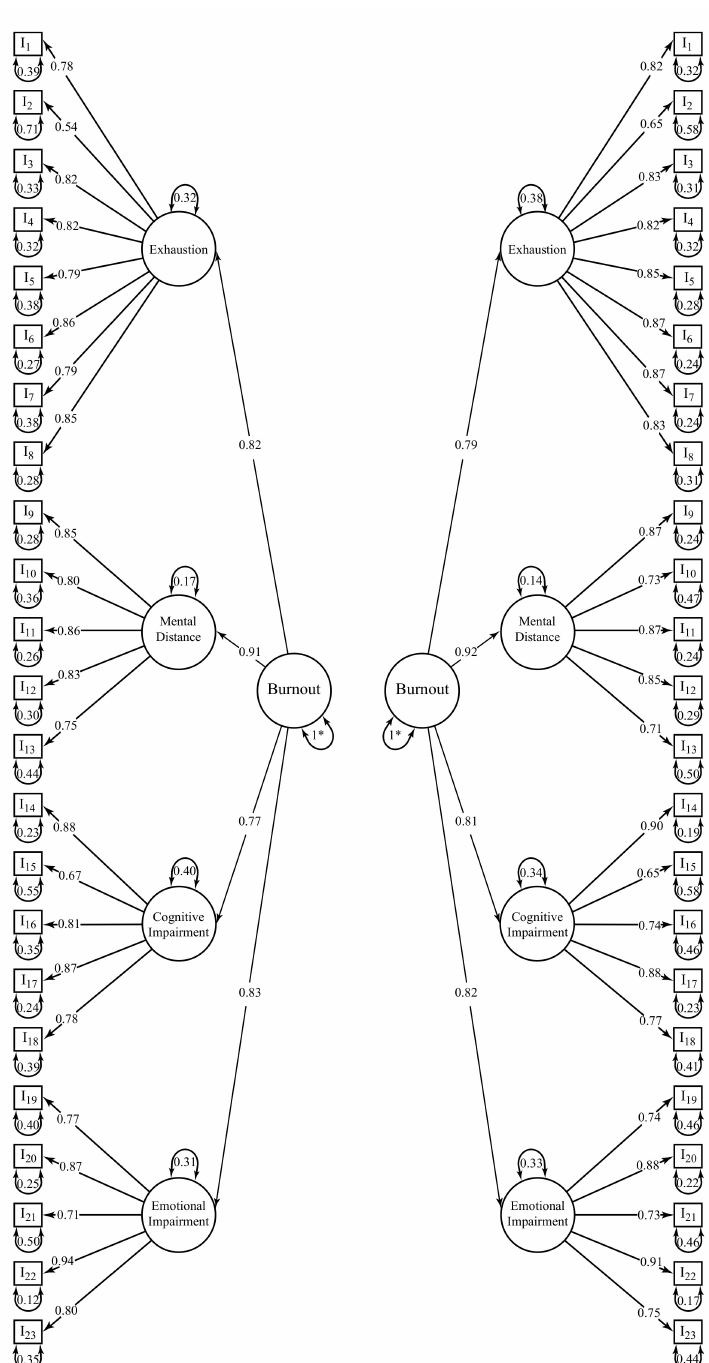
Figure 1. BAT-23’s factor loadings ( λ ) and structural weights ( γ ) for Brazil ( left ) and Portugal ( right ). * Indicates a fixed parameter. All paths were statistically significant ( p <